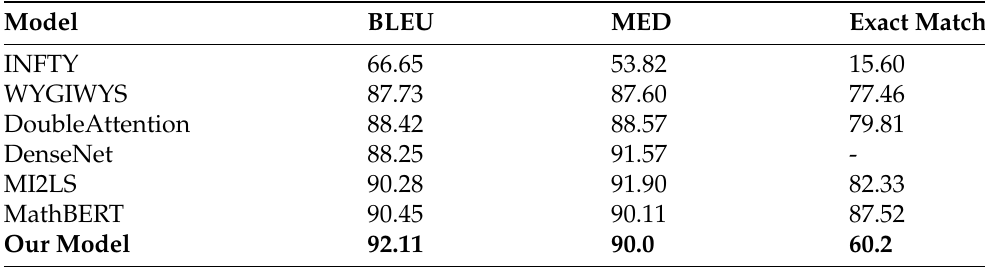
Table 4. The total efficiency of the model when there is no distinction between single-line and multi-line formulas on img2latex